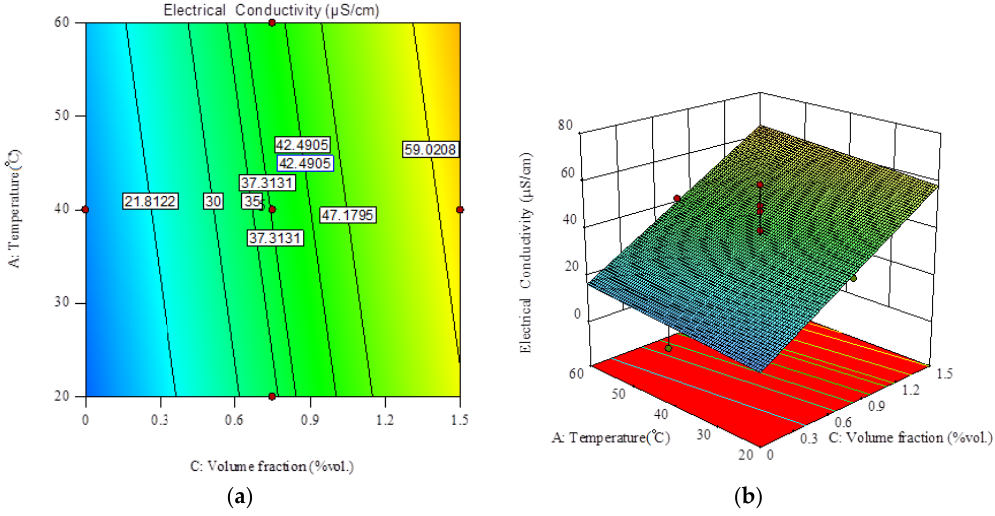
Figure 12. Effect of temperature and volume fraction variations on the electrical conductivity of CuO/glycerol. ( a ) 2 dimensional; ( b ) 3 dimensional. Energies 2018 , 11 , x FOR PEER REVIEW